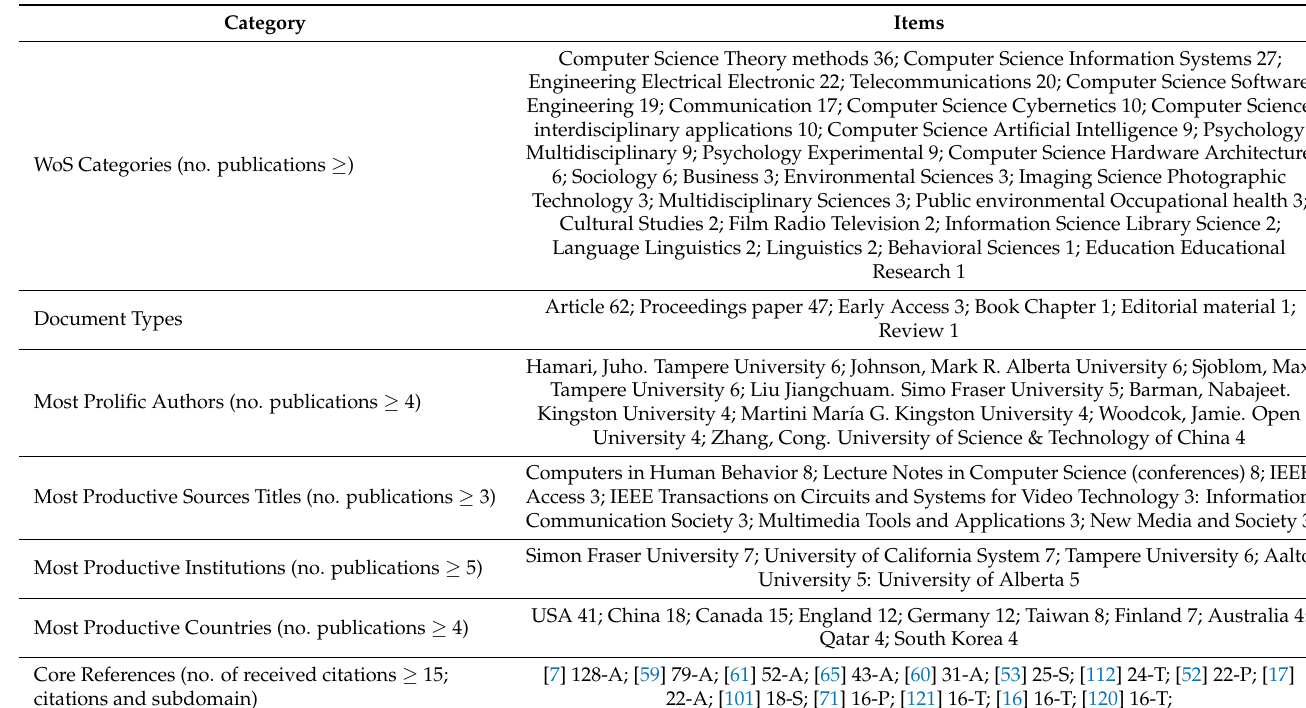
Table 4. General document profiling of research on video game live streaming